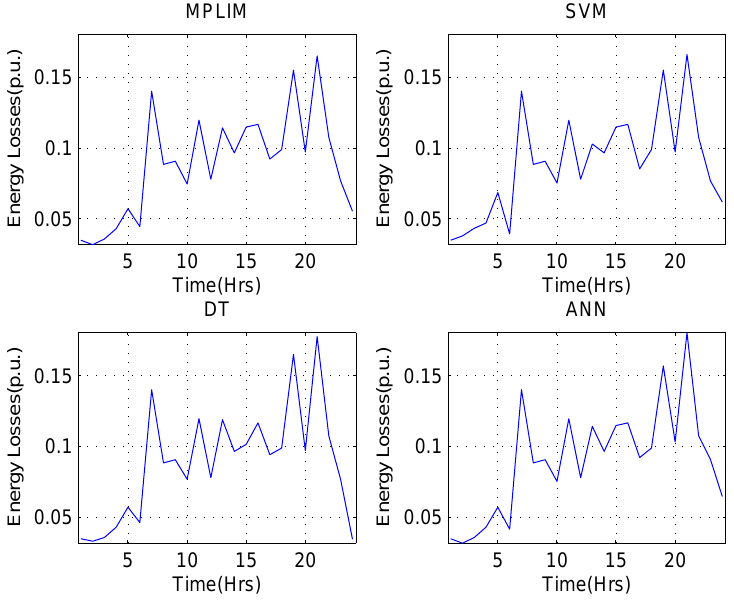
Figure 9. Energy losses calculated for 24